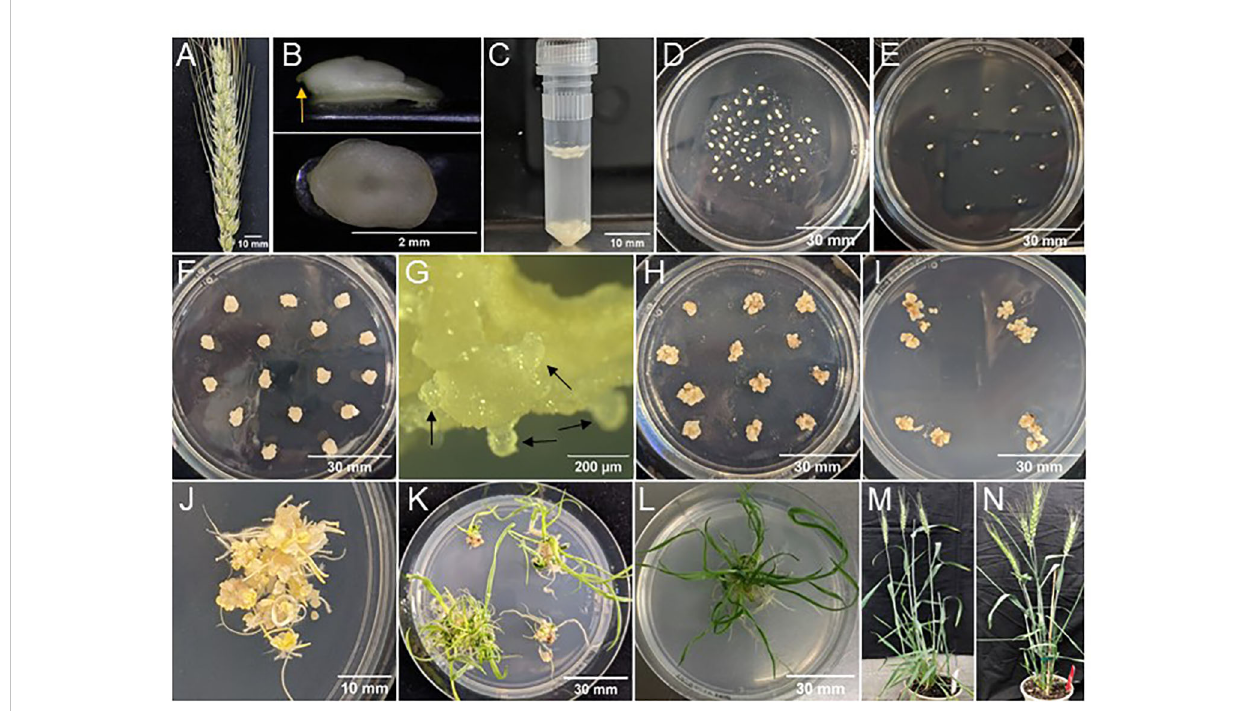
FIGURE 2 Tissue culture response using morphogenic genes in spring wheat SBC0456D. (A) Selected spike at 14 days post-anthesis. (B) Isolated immature embryo ranging from 1.8-2.1 mm in length. The top photo shows the embryo in pro fi le, with an arrow pointing to the radicle. The bottom photo shows the scutella face of the embryo. (C) Approximately 50 immature embryos in an infection tube prior to centrifugation. (D) Immature embryos with scutellum side up, on co-cultivation medium immediately following infection. (E) Immature embryos with scutellum side up on resting medium, one day after co-cultivation. (F) Callus induction of immature embryos at the end of resting stage. (G) Close look of somatic embryo formation (few examples indicated by the arrows) at the end of resting stage. (H) Proliferation of transformed tissue at the end of callus induction with selection before heat shock treatment. (I) Embryogenic callus-tissue from four immature embryos were broken into several pieces and put onto regeneration and elongation medium either with or without selection based on QuickWheat transformation methods. (J) Shoot and root initiation on regeneration medium after 2 weeks in the dark. (K) Regeneration and elongation of shoots and roots after 14 days under LED light before plantlets were separated. (L) Separated and fully developed individual T0 plant ready to be sent to controlled environments. (M) Morphology of wild-type plant germinated from seed. (N) Normal and fertile T0 event carrying two copies of ZmWUS2 and ZmBbm . (A-G) Photos representing the common tissue culture stages for both non-excision and excision wheat transformation methods. (H) Photo representing the unique tissue culture stage for excision wheat transformation method. (I-L) Photos representing the relatively similar tissue culture stages for both non-excision and excision wheat transformation